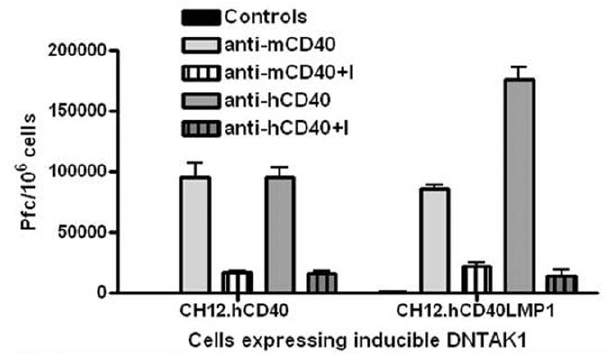
Figure 2. Requirement of TAK1 in CD40- and LMP1-mediated Ab production. CH12.hCD40 or CH12.hCD40LMP1 cells were treated with medium alone or IPTG for 18 h to induce DN-TAK1 prior to stimulation with anti-CD40 Abs, where anti-mCD40 Ab induced signaling by endogenous mCD40, and anti-hCD40 Ab induced signaling via either hCD40 (left) or hCD40LMP1 (right). After 72 h, samples were assayed for IgM production by hemolytic plaque assay. Data are presented as plaque-forming cells (Pfc, IgM-producing cells) per 10 6 viable recovered cells, mean values 6 SEM of replicate samples, and are representative of 3 independent experiments.